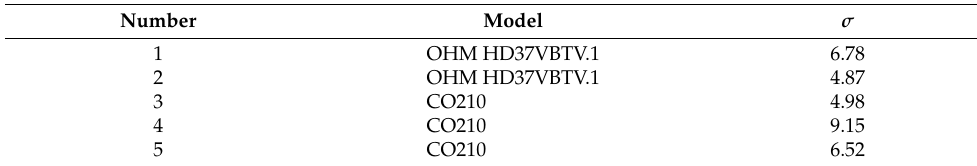
Table 2. Standard deviation ( σ ) values in % of each sensor from the average CO 2